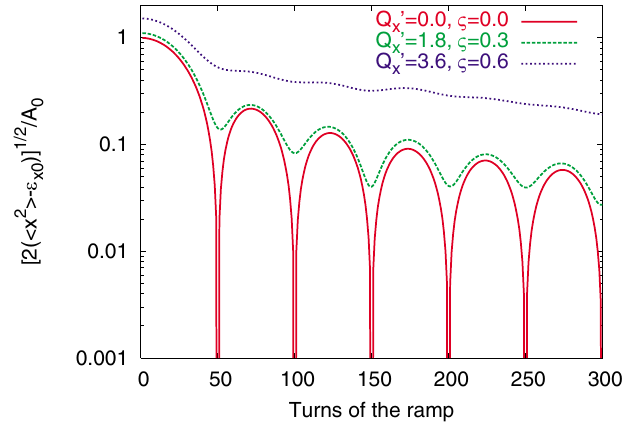
FIG. 5. (Color) Square root of twice the emittance blowup normalized to the amplitude of the driven oscillation with ; A versus the turns of the ramp for three different frequency Q D 0 values of the